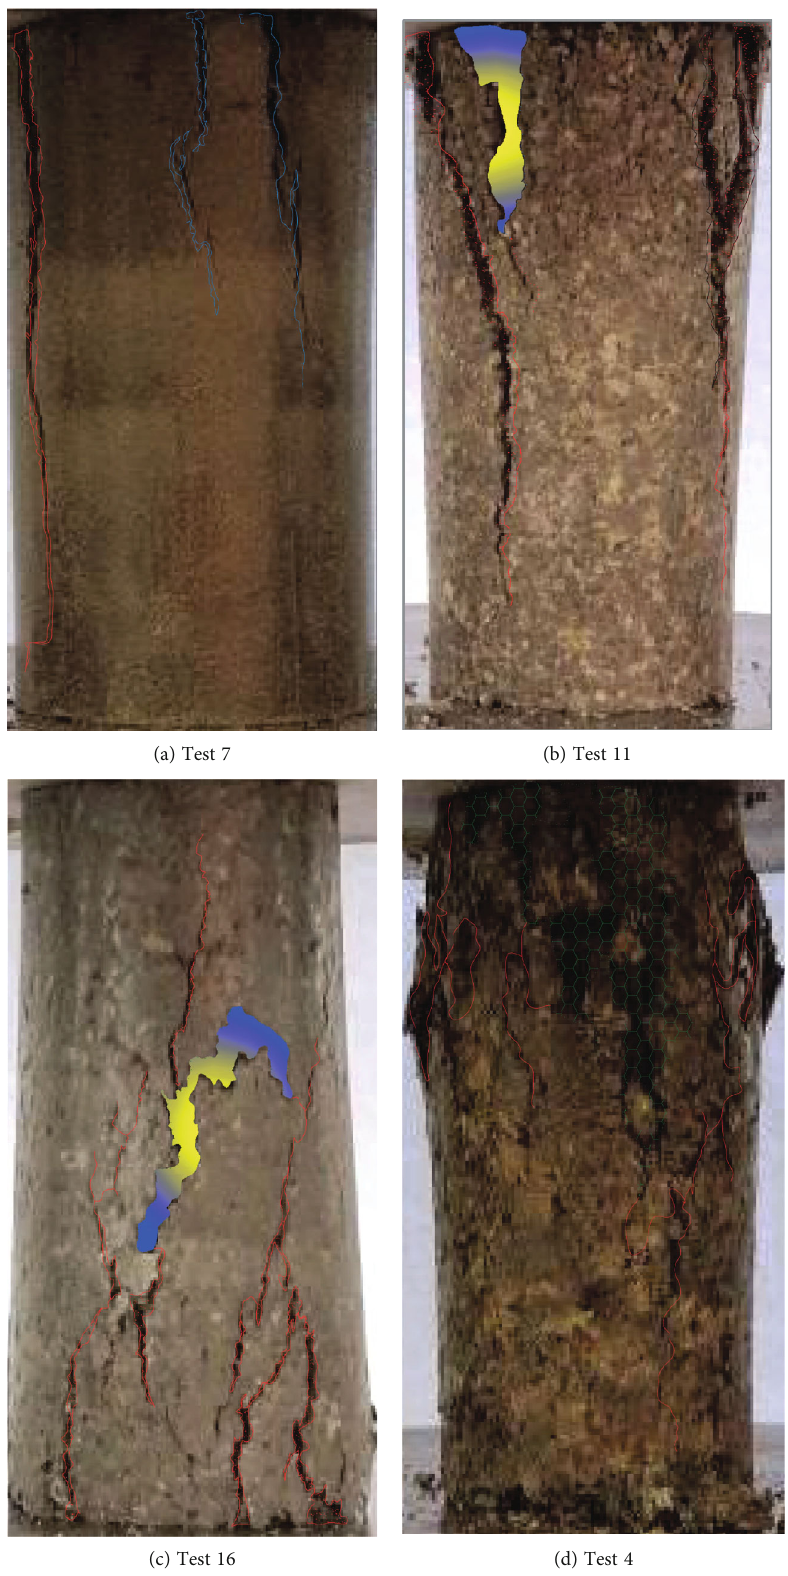
Figure 6: Uniaxial compression failure characteristics of the consolidated